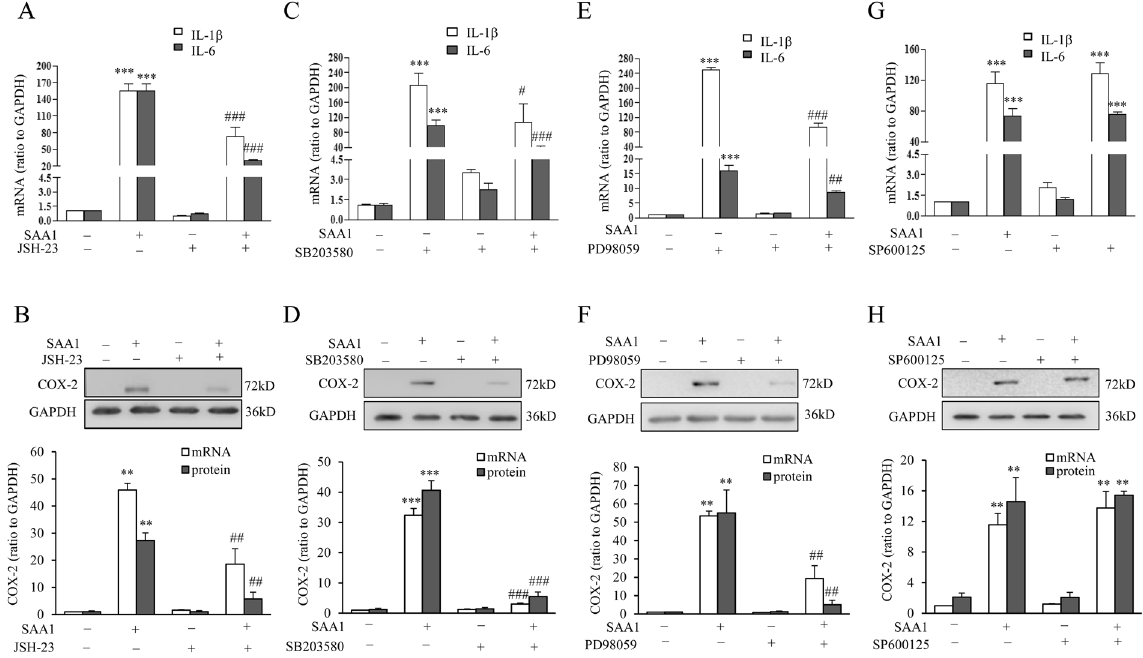
Figure 5. Role of NF- κ B, p38, ERK1/2 and JNK in the induction of IL-1 β , IL-6 and COX-2 by SAA1 in human amnion fibroblasts. ( A and B ) Effect of NF- κ B inhibitor JSH-23 (10 µ M) on SAA1 (10 ng/mL, 24 hours)-induced changes in IL-1 β , IL-6 mRNA ( A , n = 4), COX-2 mRNA and protein ( B , n = 3) in human amnion fibroblasts. ( C and D ) The effect of p38 inhibitor SB203580 (10 µ M) on SAA1 (10 ng/mL, 24 hours)-induced IL-1 β , IL-6 mRNA ( C , n = 4), COX-2 mRNA and protein ( D , n = 3) in human amnion fibroblasts. ( E and F ) Effect of ERK1/2 inhibitor PD98059 (20 µ M) on SAA1 (10 ng/mL, 24 hours)-induced IL-1 β , IL-6 mRNA (E, n = 4), COX-2 mRNA and protein ( F , n = 3) in human amnion fibroblasts. ( G and H ) Effect of JNK inhibitor SP600125 (20 µ M) on SAA1 (10 ng/mL, 24 hours)-induced IL-1 β , IL-6 mRNA ( G n = 4), COX-2 mRNA and protein ( H ) n = 3) in human amnion fibroblasts. Top panels of ( B,D,F and H ) are the representative immunoblots. Data are the means ± SEM. Statistical analysis was performed with one-way ANOVA test. ** P < 0.01, *** P < 0.001 vs. control (0), # P < 0.05, ## P < 0.01, ### P < 0.001 vs.